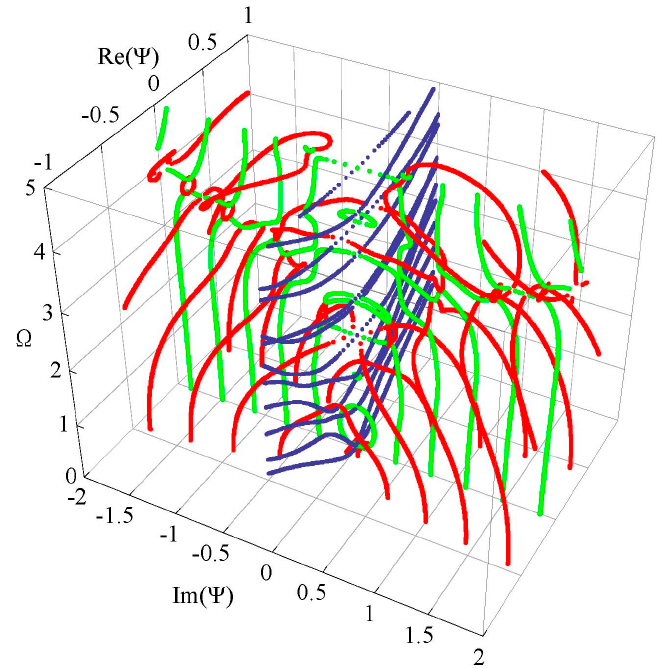
Figure 5. Complete frequency spectrum of a Lamb-like wave in a linear functionally graded piezoelectric material (FGPM) spherical curved plate; real branch in blue, purely imaginary branch in green, complex branch in red.